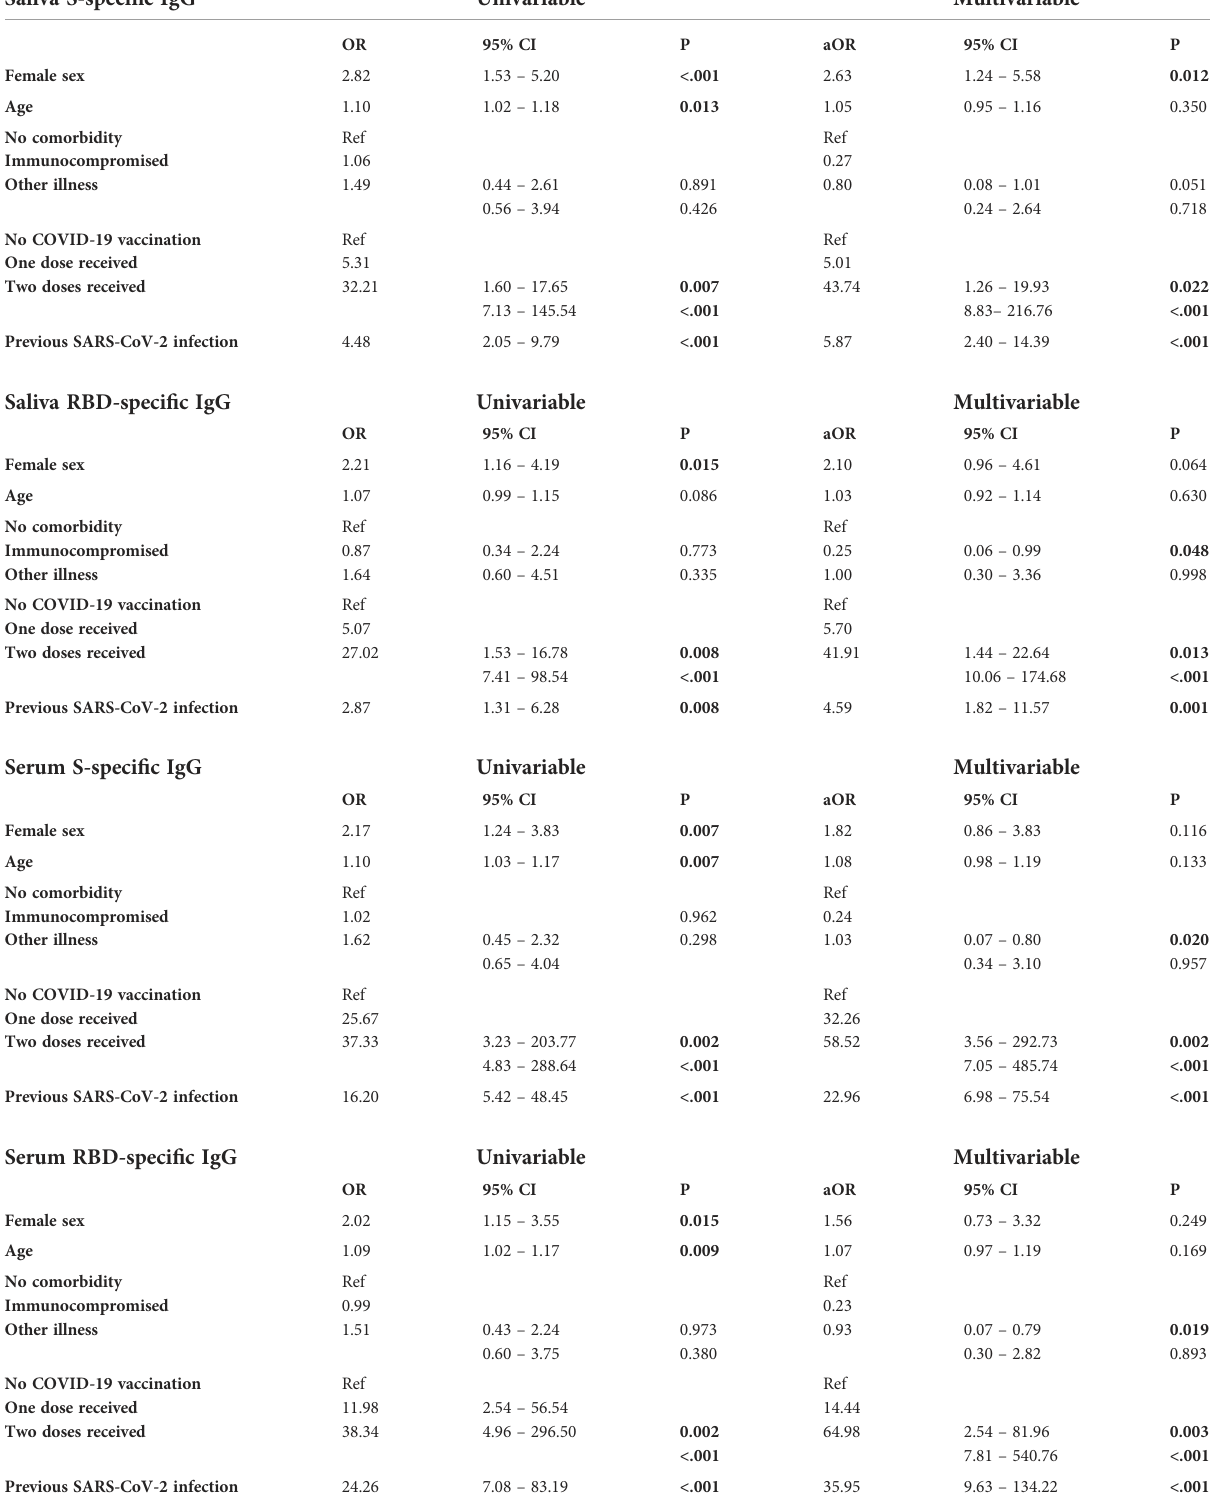
TABLE 2 Logistic regressions for serum and saliva IgG